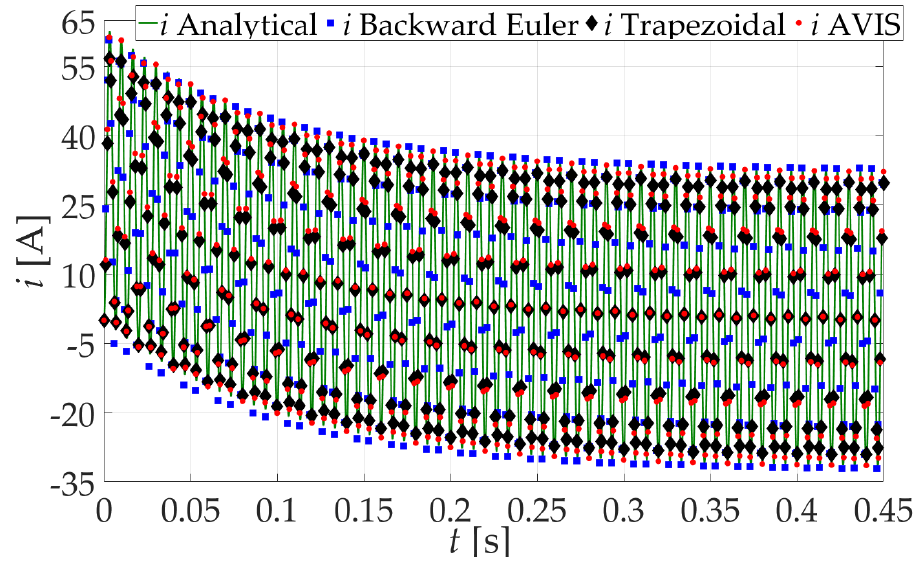
Figure 7. Current waveform caused by connecting the RL clamp to the voltage source with a frequency of 150 Hz.